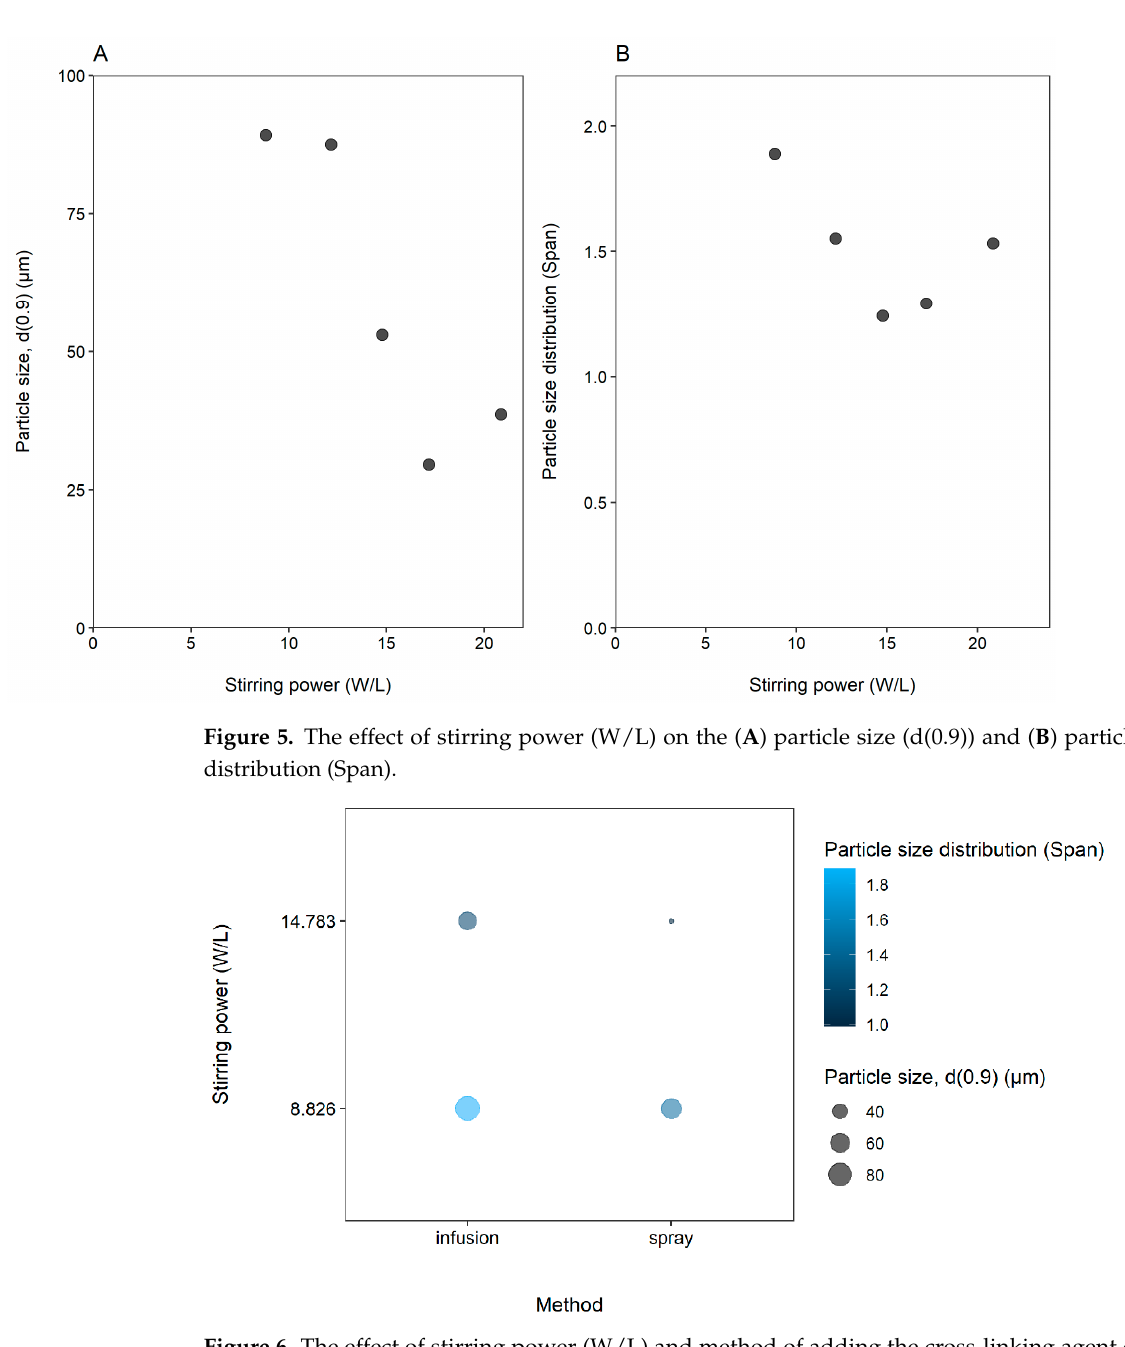
Figure 6. The effect of stirring power (W/L) and method of adding the cross-linking agent on the microparticle size as (d(0.9)) and microparticle size distribution (Span).